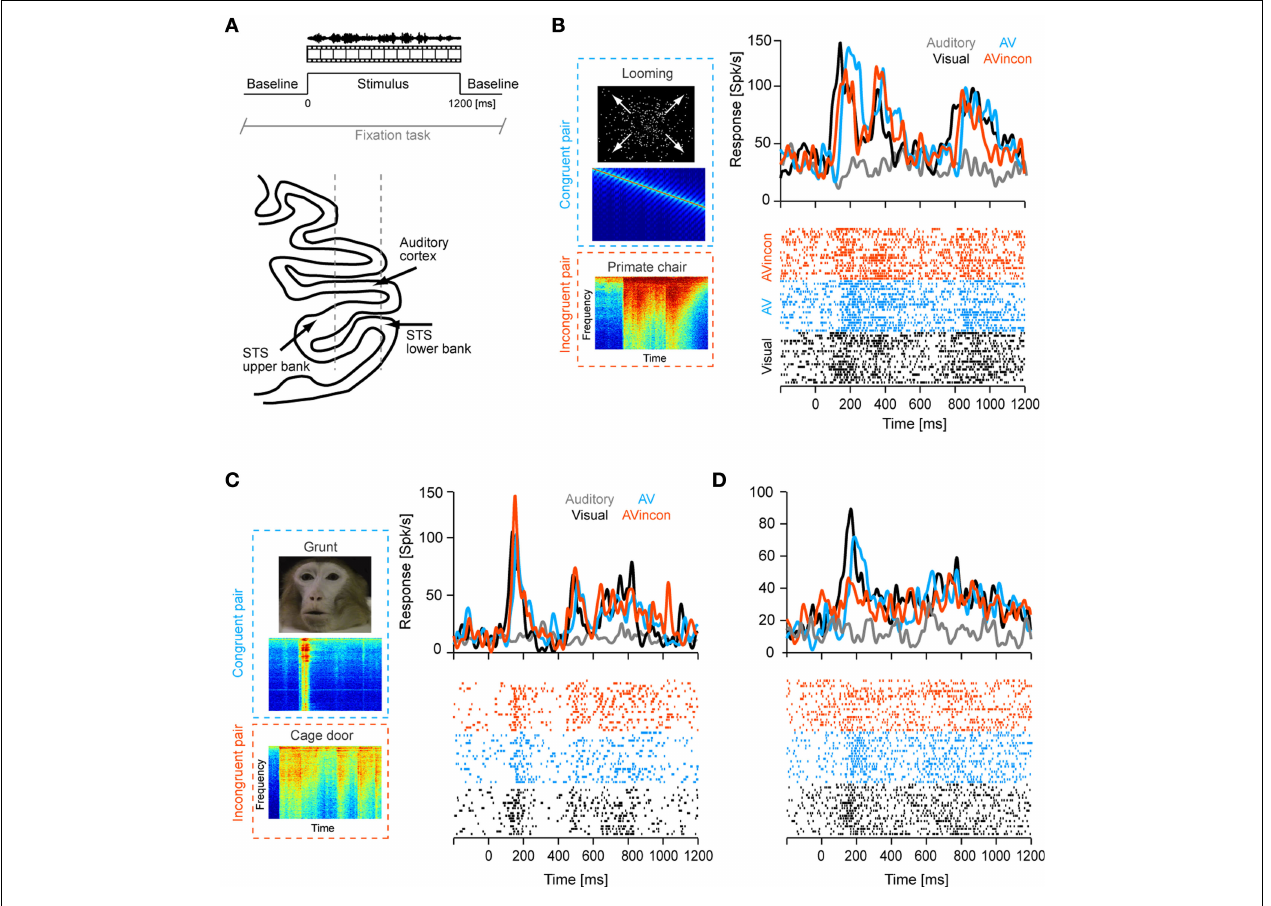
FIGURE 1 | Example data. (A) The upper panel illustrates the experimental paradigm. Visual, auditory and combined audio-visual stimuli were presented while the animals performed a visual fi xation task and were separated by baseline periods (silence, gray screen). The lower panel illustrates the recording approach to the lower bank STS. (B–D) Example responses of three units. Line graphs depict the trial-averaged fi ring rate (smoothed by a 20-ms Gaussian